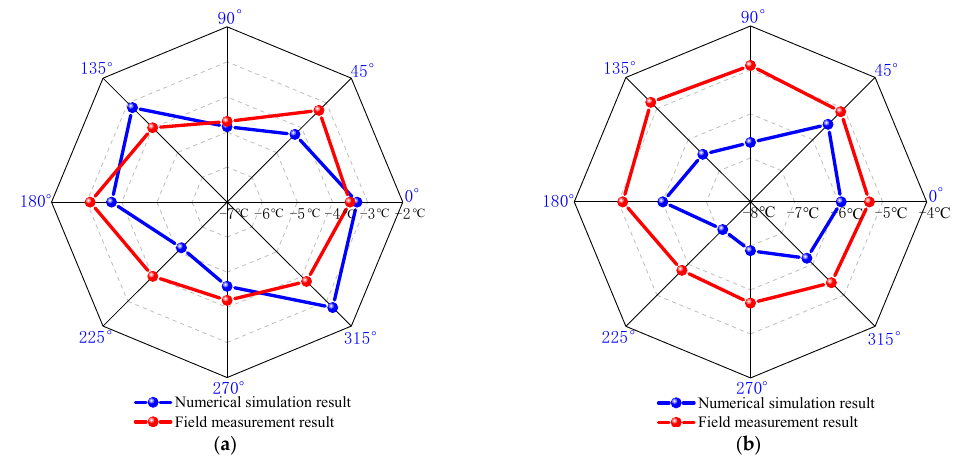
Figure 7. Comparisons of measured and simulated side wall temperatures. ( a ) Side wall temperature of − 87 m fine sandy soil; ( b ) side wall temperature of − 135 m fine sandy soil.